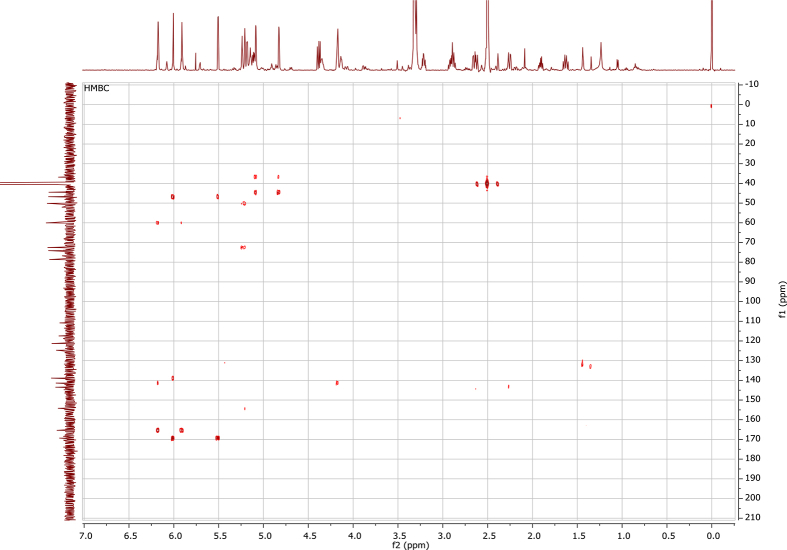
HMBC (DMSO-d6) spectrum of compound 12.